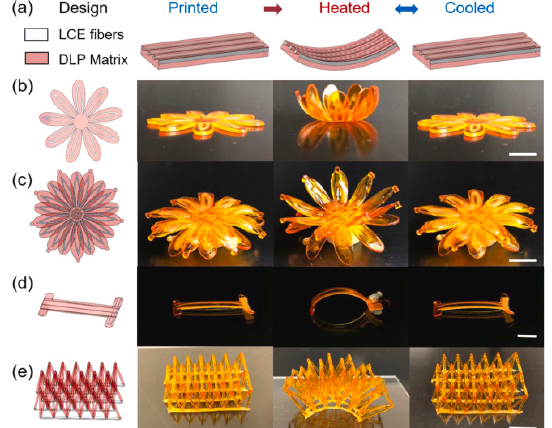
Figure 41 . Several soft robot prototypes printed with a DLP–DIW hybrid method, with the four structure designs shown in ( b – e ) and a colour-coded key for the different materials in ( a ). These active structures are shown after printing ( left ), during heating/actuation ( middle ), and after cool- ing/relaxation ( right ). The structures are printed with layer thicknesses of 50 μ m (for the DLP polymer matrix) and 700 µ m (for the DIW LCE fibres), and the scale bar is 10 mm [165]. (Reprinted from Additive Manufacturing, Volume 40, X. Peng, et al., ‘Integrating digital light processing with direct ink writing for hybrid 3D printing of functional structures and devices’, Copyright (2021), with permission from Elsevier).